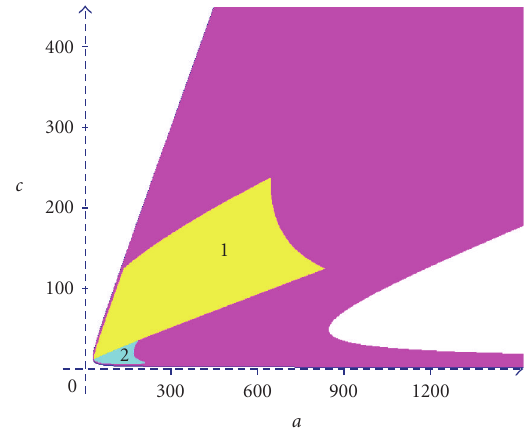
Figure 5.3 . Region of su ffi cient stability condition for (5.2): p = 12, h = 0 . 024, Δ = 0 .